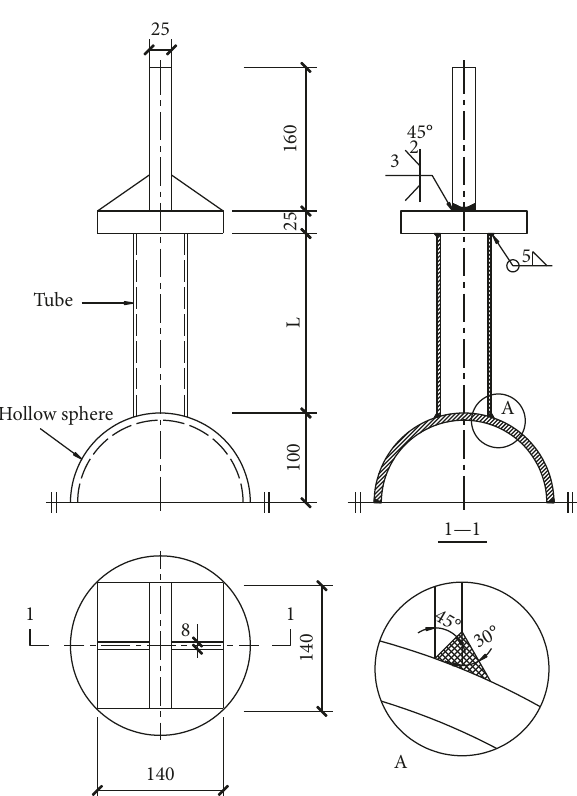
Figure 3: Specimen dimensions (unit: mm). Table 1: Specimen ID and geometric parameters. Specimen label